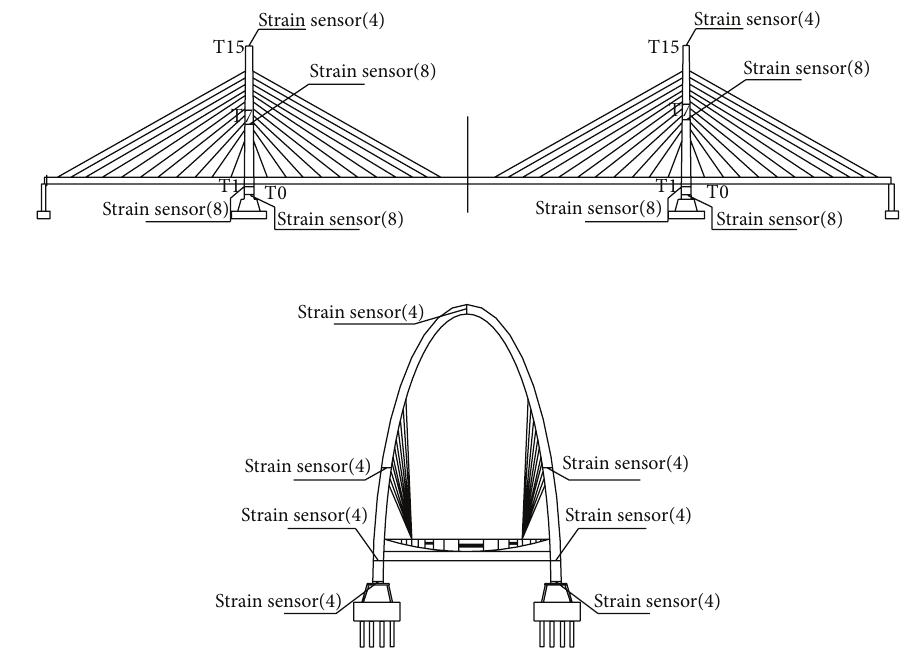
Figure 10: Stress and fatigue monitoring points on the steel tower.